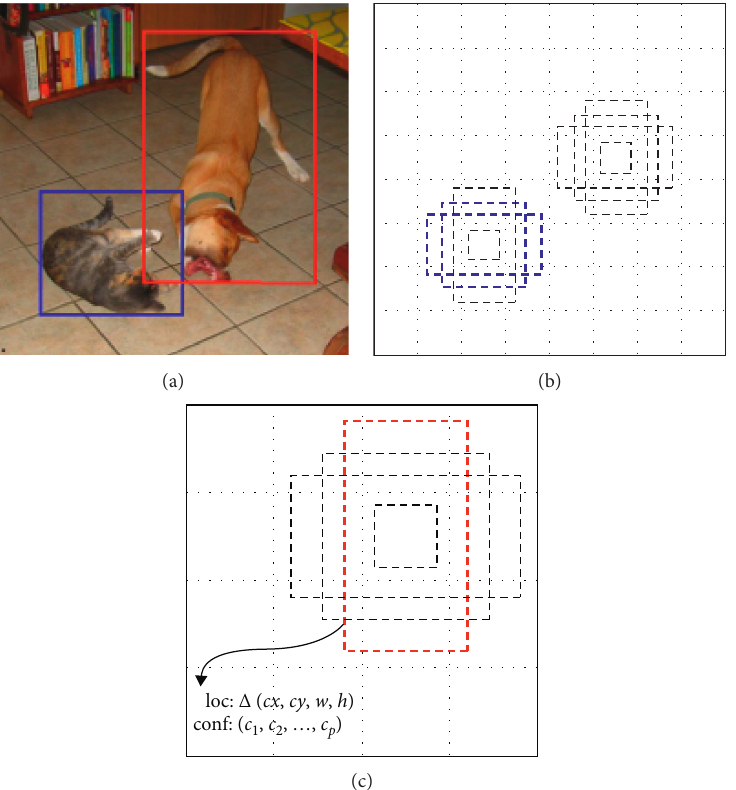
Figure 4: The location of the default boxes in different scales: (a) image with GT boxes; (b) 8 × 8 feature map; (c) 4 × 4 feature